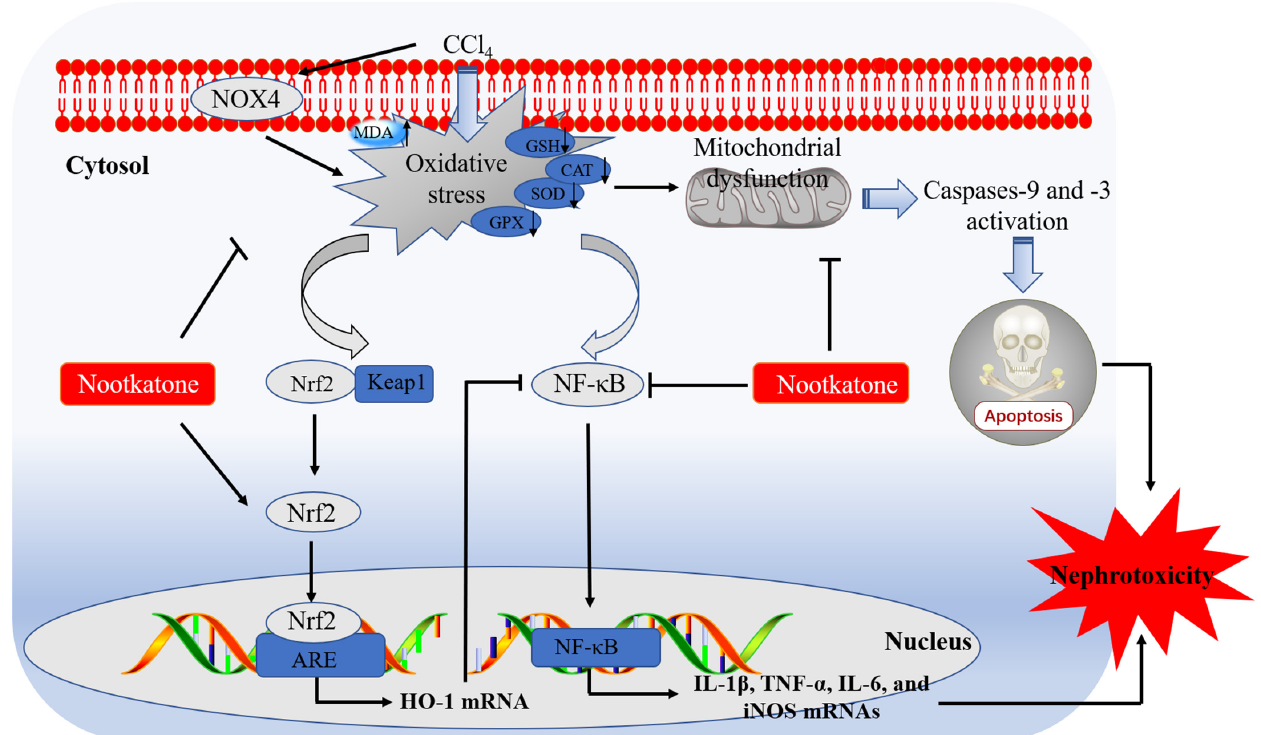
Figure 10. Pathways of NKT supplementation protecting against CCl4 exposure -induced nephrotoxicity. MDA, malondialdehyde; SOD, superoxide dismutase; CAT, catalase; GSH, glutathione; GPX, glutathione peroxidase; Keap1, kelch like ECH associated protein 1; Nrf2, NF-E2- related factor; HO-1, heme oxygenase-1; NOX4, NADPH oxidase 4; NF- κ B, nuclear factor-kappaB; iNOS, inducible nitric oxide synthase; IL-1 β , interleukin-1 β ; IL-6, interleukin-6; TNF- α , tumor necrosis factor- α ; ARE, antioxidant response